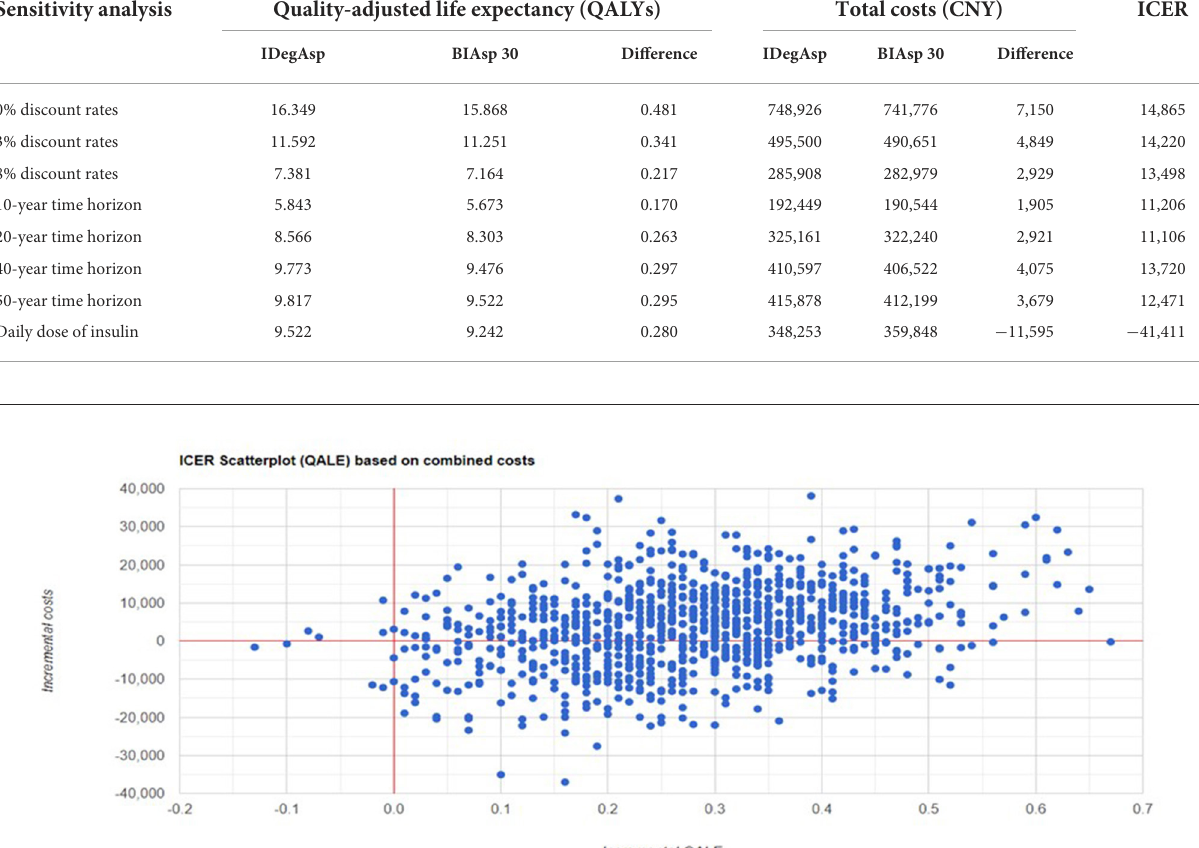
TABLE 3 One-way sensitivity analyse.